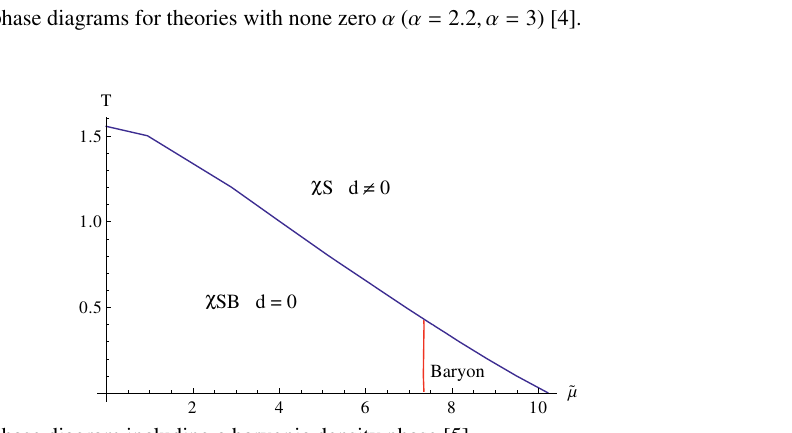
Figure 6. Sample phase diagram including a baryonic density phase